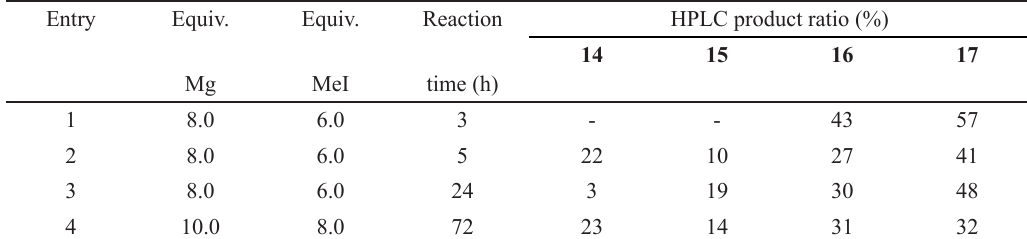
the preparation of 14 (Experimental section). BnOH N N O 17 aqueous work-up O OMgI MeMgI MeMgI Bn 11 N Bn N Bn N N O O 13 16 18 19 MeMgI 217 MeMgI 6 N Bn Bn N N 5 N 3 4 O 14 19b